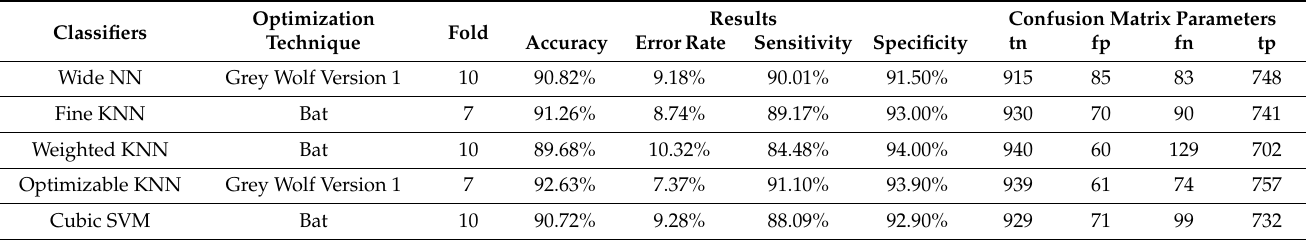
Table 8. Performance of various classifiers using GLCM and Hu’s invariant moments.